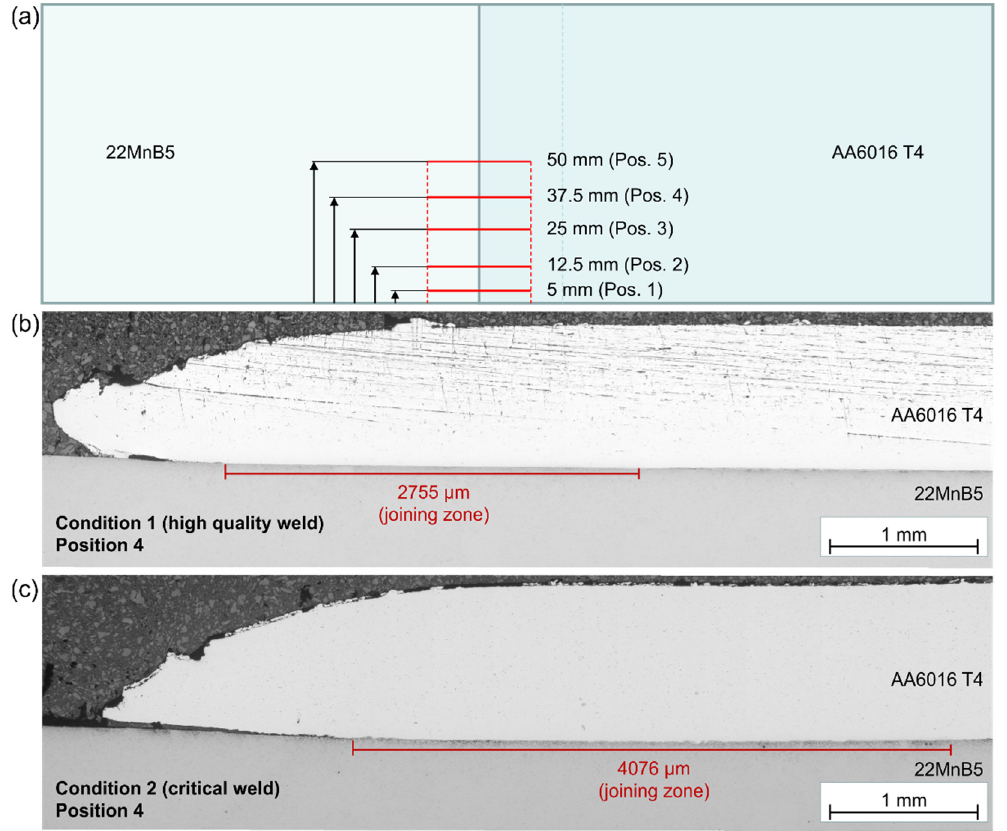
Figure 7. ( a ) Positions of cross-sections at varying distances from the edge of the Al/steel compound. ( b ) Optical microscope image of the cross-section of a high-quality weld (condition 1, position 4), ( c ) Optical microscope image of the cross-section of a critical weld (condition 2, position